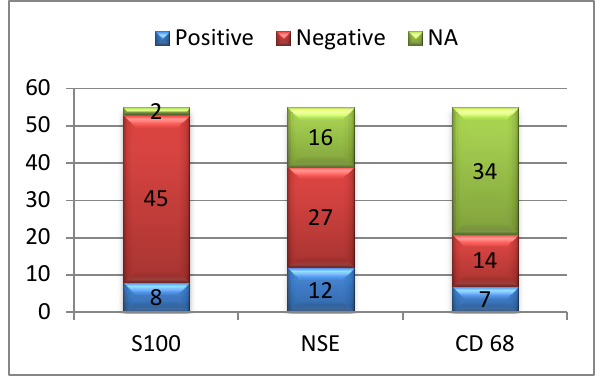
Figure 3: Immunohistochemistry marker used in congenital Granular cell tumor